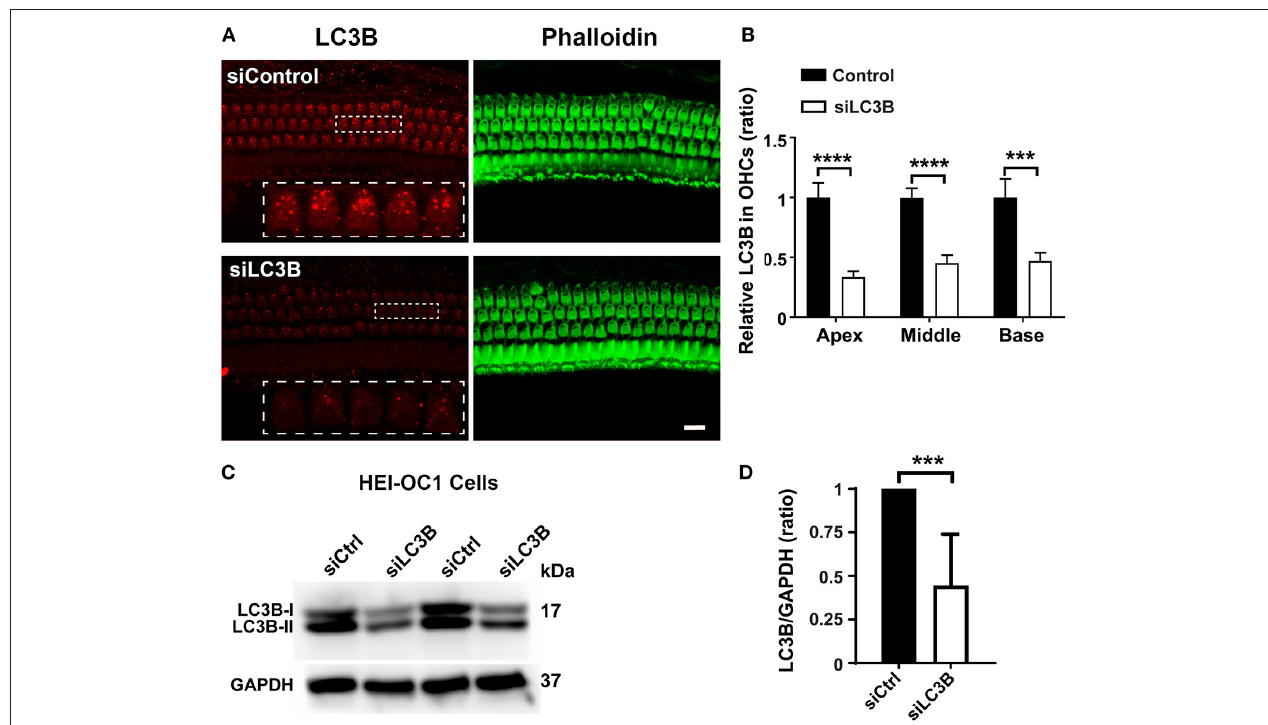
FIGURE 5 | Downregulation of LC3B by LC3B-siRNA both in vivo and in vitro . (A) Surface preparations immunolabeled with LC3B reveal decreased immunolabeling for LC3B (red) in outer hair cells (OHCs) assessed 72h after the intra-tympanic delivery of LC3B-siRNA. The representative images were taken from the basal turn corresponding to sensitivity to 22–32kHz. The apical and middle turns showed a similar attenuation of LC3B. Green, phalloidin staining for sensory hair cells. Scale bar = 10 µ m. (B) Quantification of LC3B immunolabeling intensity in grayscale in OHCs in the apical (corresponding to sensitivity to 8kHz), middle (corresponding to sensitivity to 16kHz), and basal turns (corresponding to 22–32kHz) confirms a significant decrease. Data are presented as means ± SD, n = 4; *** p < 0.001, **** p < 0.0001. (C) Representative blots show that the protein levels of LC3B decreased after 48h of transfection with the LC3B-siRNA in cells compared to the control group transfected with scrambled siRNA (siCtrl). GAPDH serves as a sample loading control. (D) Semi-quantification of the band density (both LC3B I and II) confirms a significant decrease. Data are presented as means ± SD; n = 4, *** p <